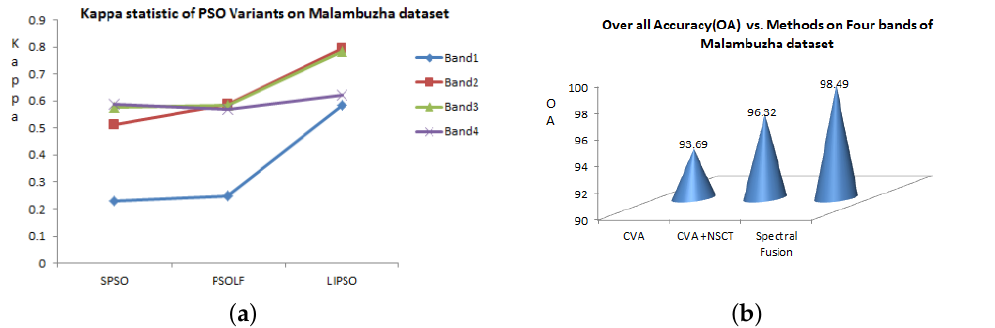
Figure 10. Comparison of Kappa statistic obtained for Malambuzha dataset using ( a ) PSO variants on various bands, and ( b ) Proposed technique on band